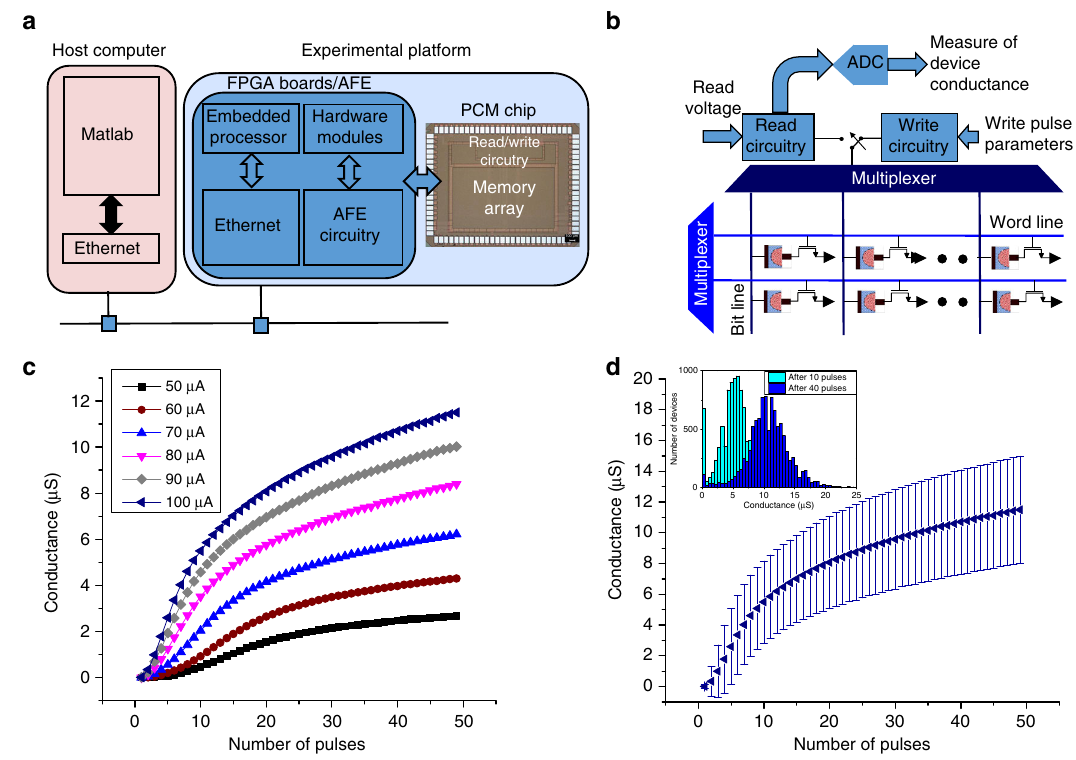
Fig. 4 Experimental platform and characterization results. a Schematic illustration of the experimental platform showing the main components. b The phase change memory array is organized as a matrix of word lines (WL) and bit lines (BL), and the chip also integrates the associated read/write circuitries. c The mean accumulation curve of 10,000 devices showing the map between the device conductance and the number of pulses. The devices achieve a higher conductance value with increasing SET current and also with increasing number of pulses. d The mean and standard deviation associated with the accumulation curve corresponding to the SET current of 100 μ A. Also shown are the distributions of conductance values obtained after application of the 10th and 40th SET